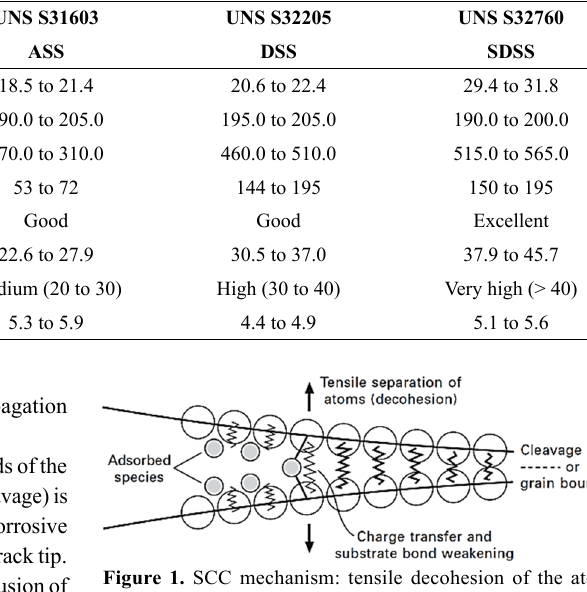
Table 1. General properties of UNS S31603, UNS S32205 and UNS S32760 stainless steels 5 . Property